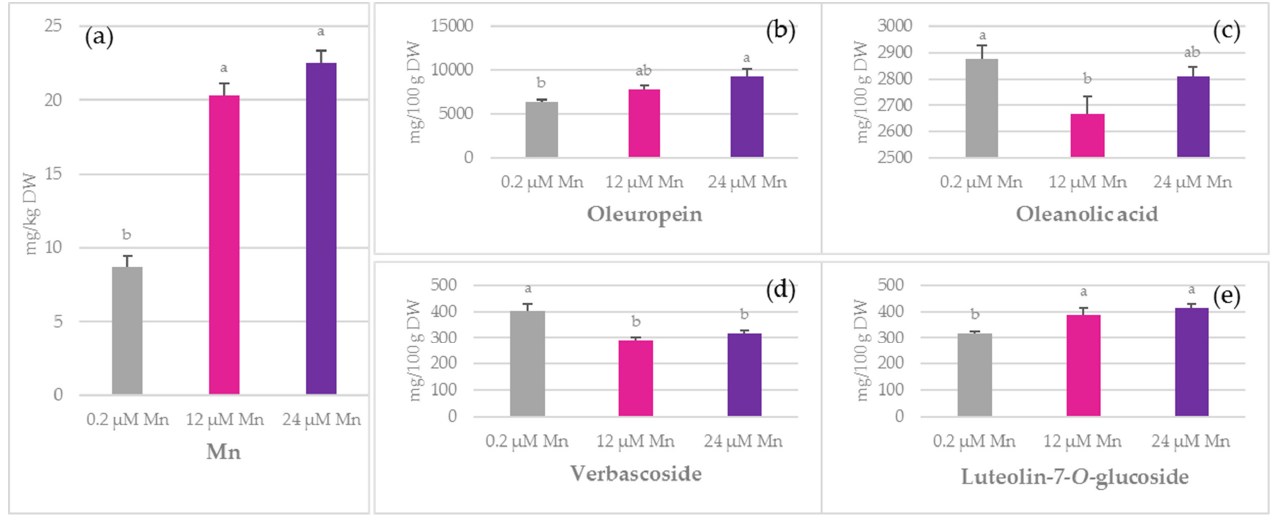
Figure 1. The effect of manganese (Mn) application on: ( a ) Mn, ( b ) oleuropein, ( c ) oleanolic acid, ( d ) verbascoside, and ( e ) luteolin-7- O -glucoside concentrations in olive leaves of ‘Istarska bjelica’ olive cv. (mean values ± SE, n = 4). Mean values followed by different letters are significantly different at p < 0.05 according to Tukey’s test. DW—dry weight.